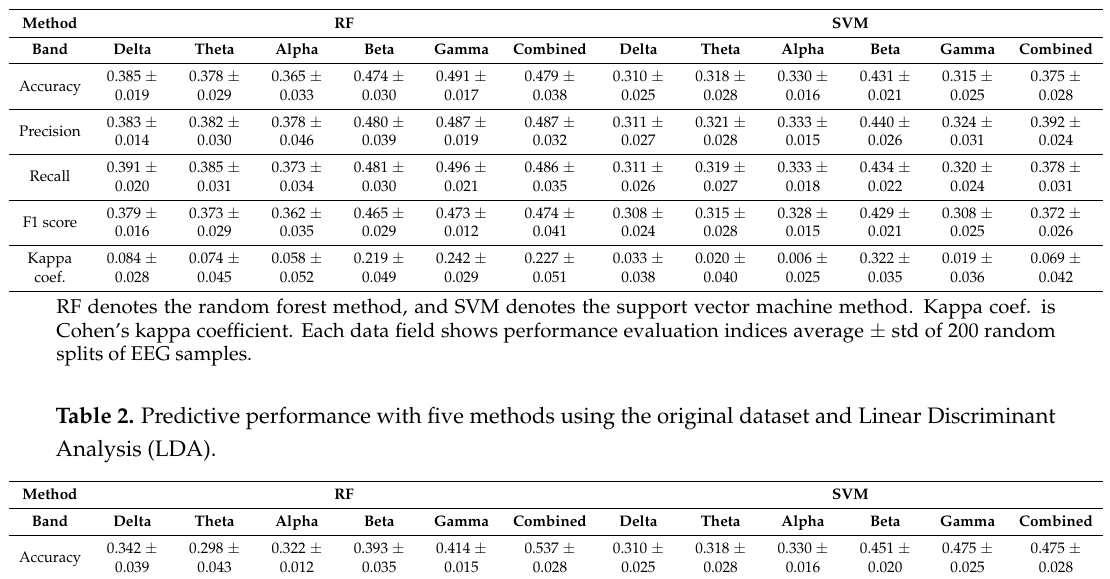
Table 1. Predictive performance of five methods using the original dataset.